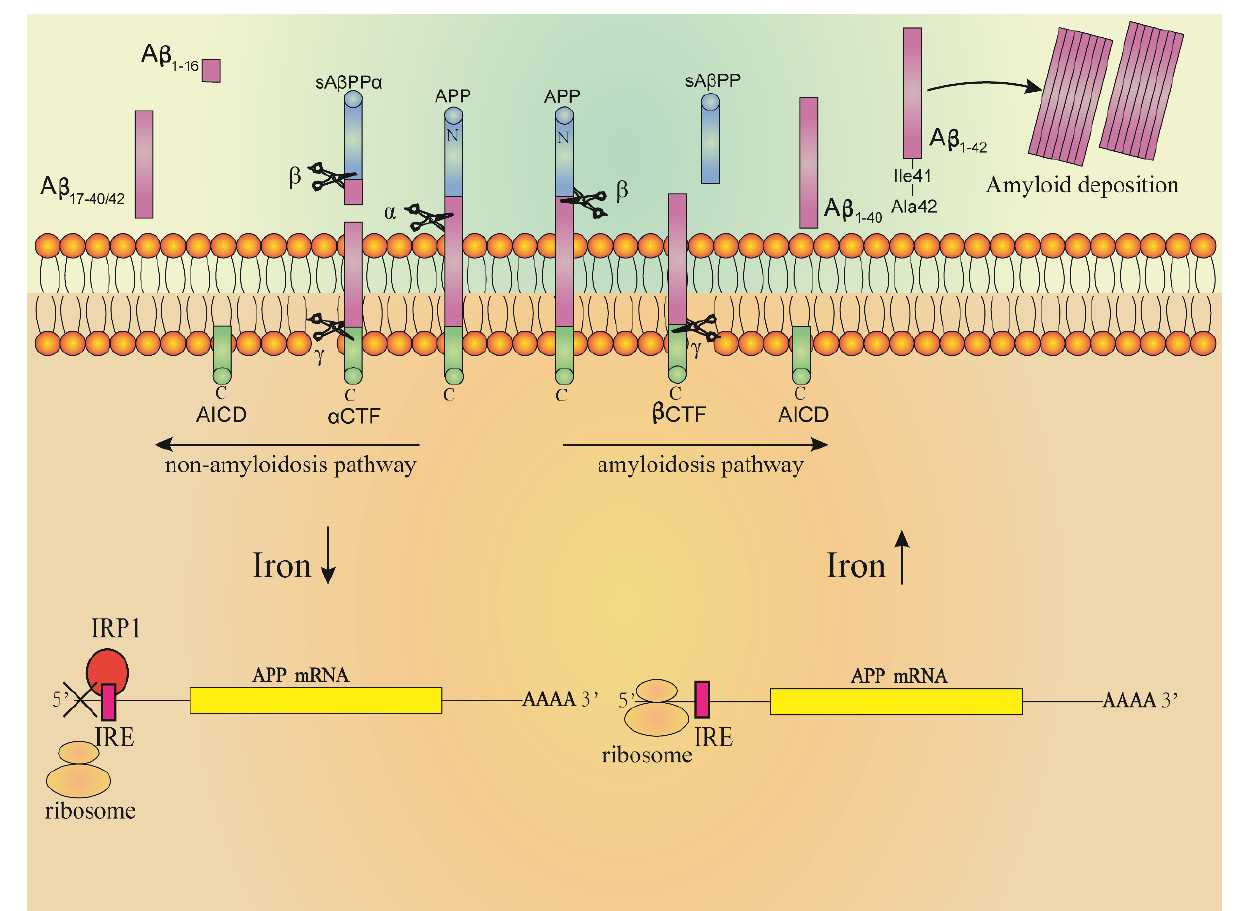
Figure 4. High concentrations of iron in neurons induce A β formation. The 5 ′ -UTR region of APP mRNA has an 11-base loop called IRE. The combination of IRPs and IRE regulates the synthesis of APP. The high concentration of iron in the cell will combine with IRP1 to form iron–sulfur clusters, and make IRP1 lose the ability to bind to IRE. At the same time, high concentrations of iron will also induce conformational changes in the IRE region of APP mRNA, which increases the expression of APP; in contrast, when the iron concentration in the cell is at a low level, IRP1 will bind to the IRE of APP mRNA, resulting in the decreased production of A β 42 . A β 1–42 aggregates to form amyloid plaques.